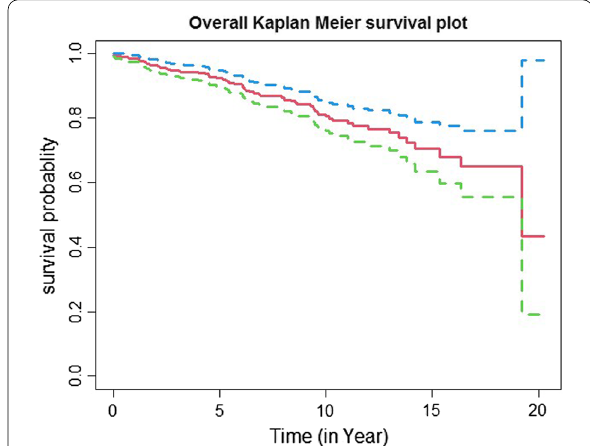
Fig. 1 Plot of the overall estimate of Kaplan–Meier for time to diabetic neuropathy among T2DM patients. The red line indicated the survival estimate, the blue and green colour line show the upper and the lower boundary of the estimate